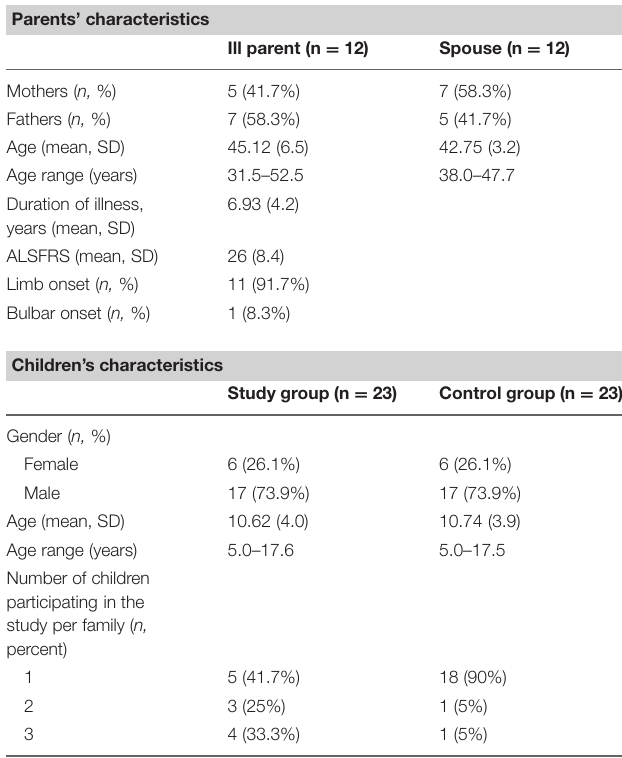
TABLE 1 | Demographic characteristics of the study sample and control